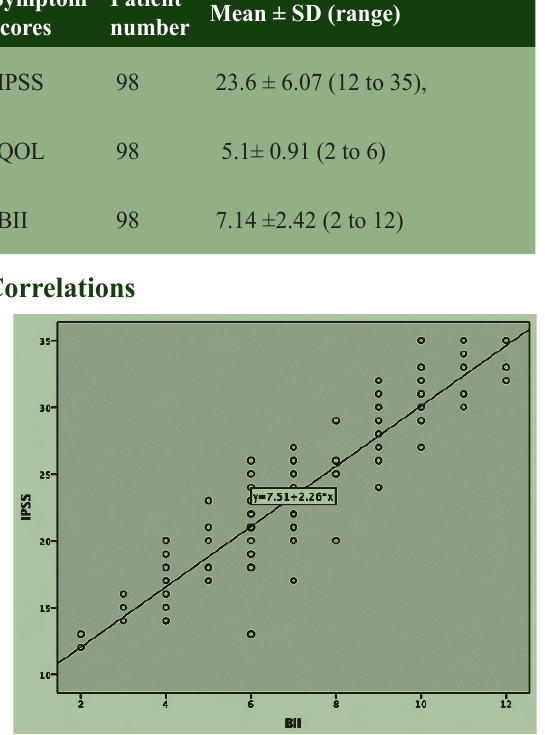
Figure 1. Scatter diagram showing correlation between IPSS and BPH II